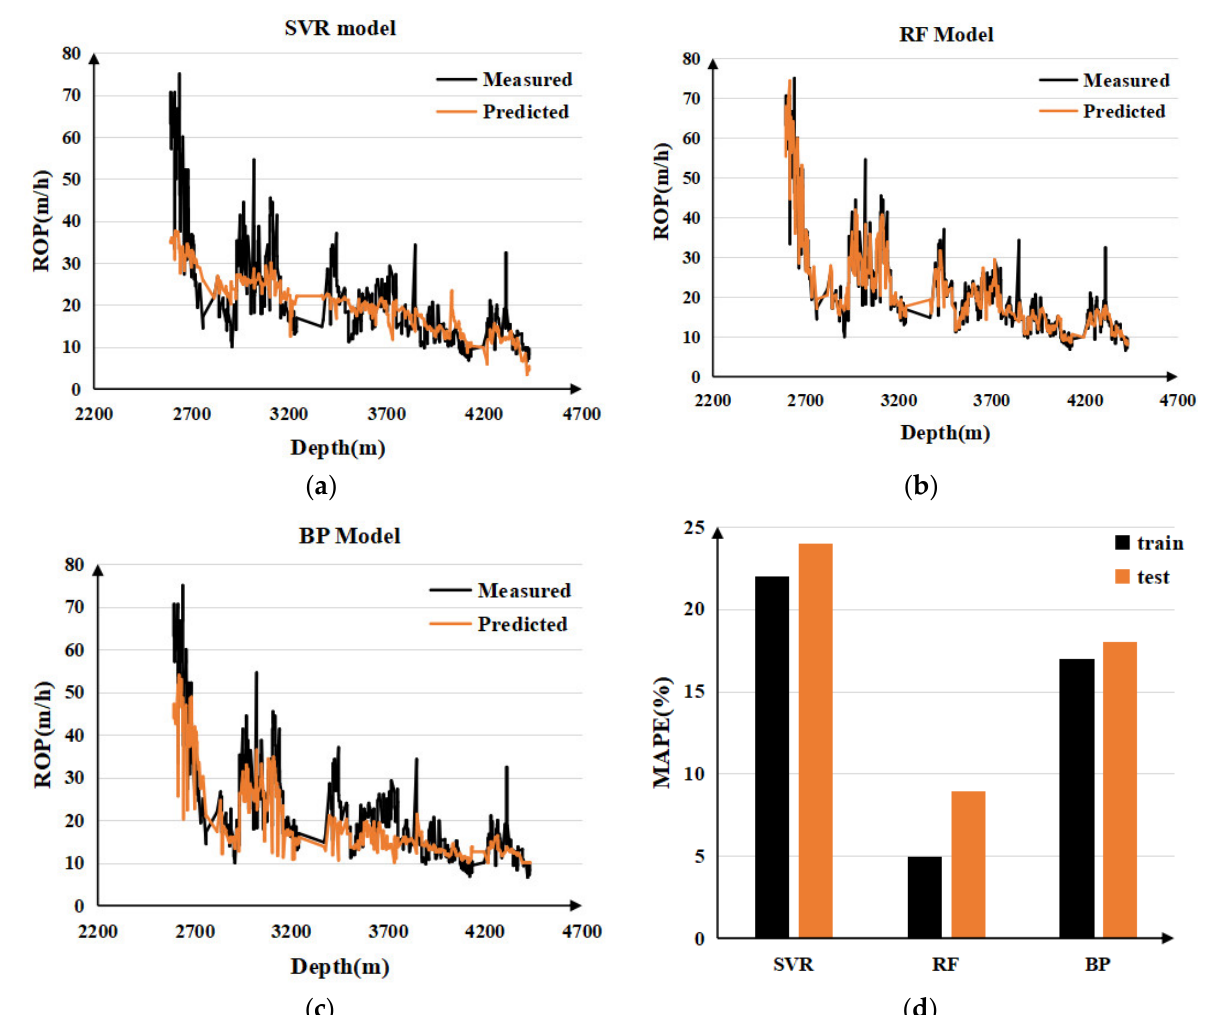
Figure 10. The prediction effect and MAPE comparison. ( a ) The prediction results of SVR model; ( b ) The prediction results of RF model; ( c ) The prediction results of BP network model; ( d ) Comparison of models accuracy.